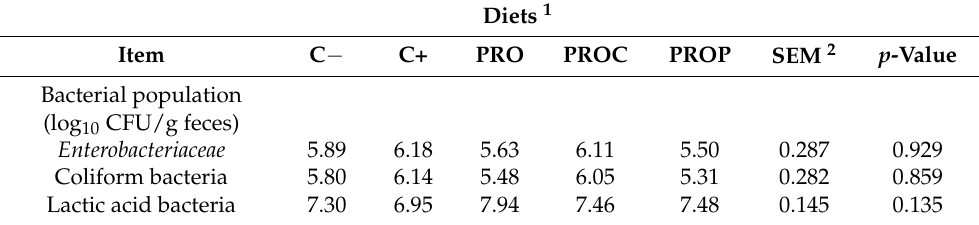
Table 3. Microbiology profile of feces from piglets fed the experimental diets at 26 days